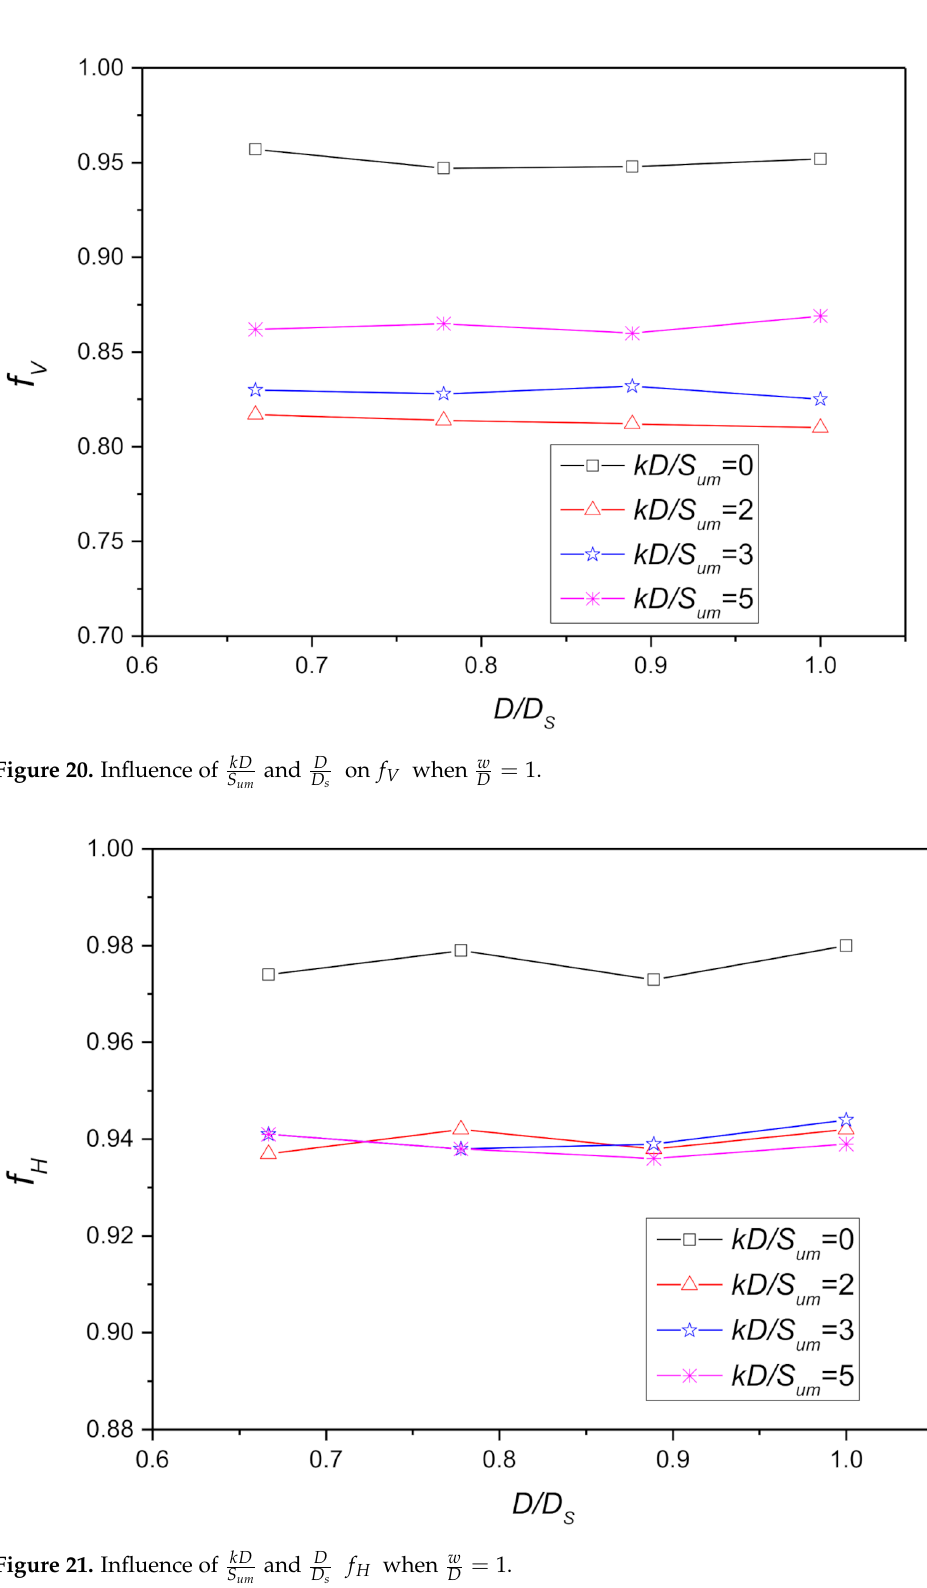
Figure 21. Influence of kD